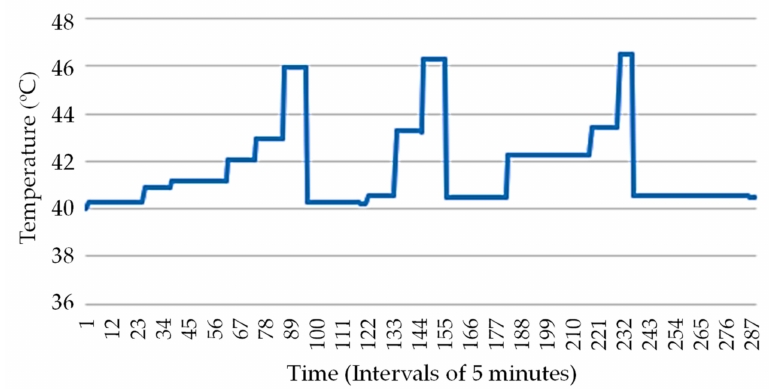
Figure 8. Evolution of the temperature in the sanitarian water heater tank, during the day, considering the critical peak pricing